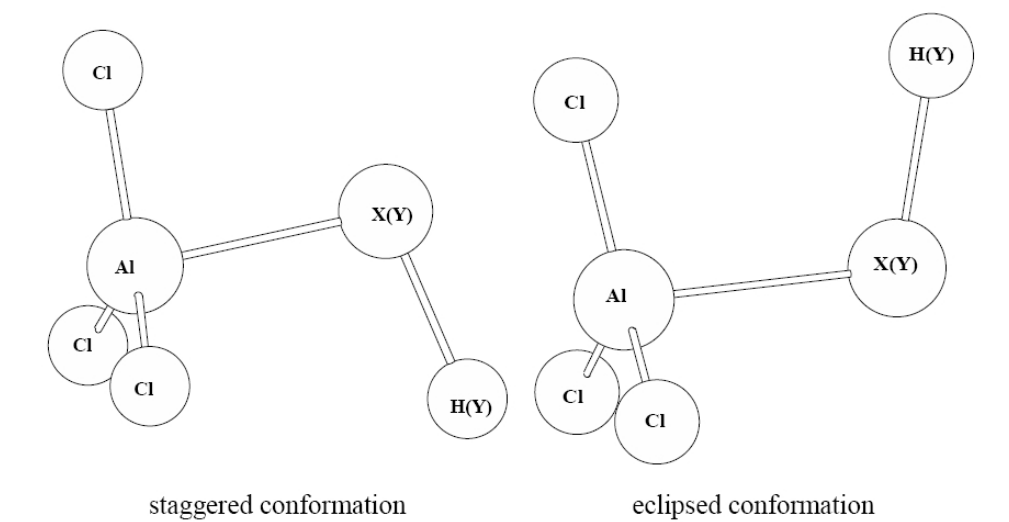
Fig. 1 Structural representations of Cl and Br)